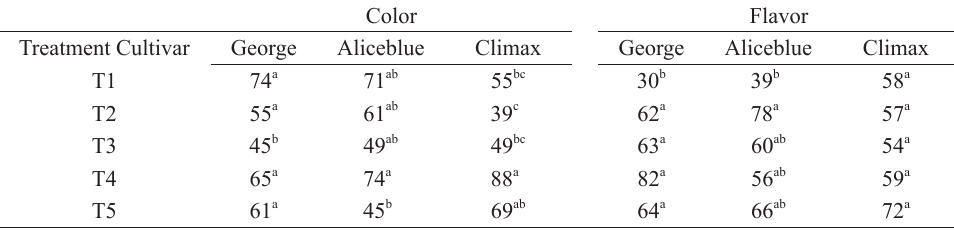
Ranking sums of blueberry wine evaluated by the preference test. Color Flavor Treatment Cultivar George Aliceblue Climax